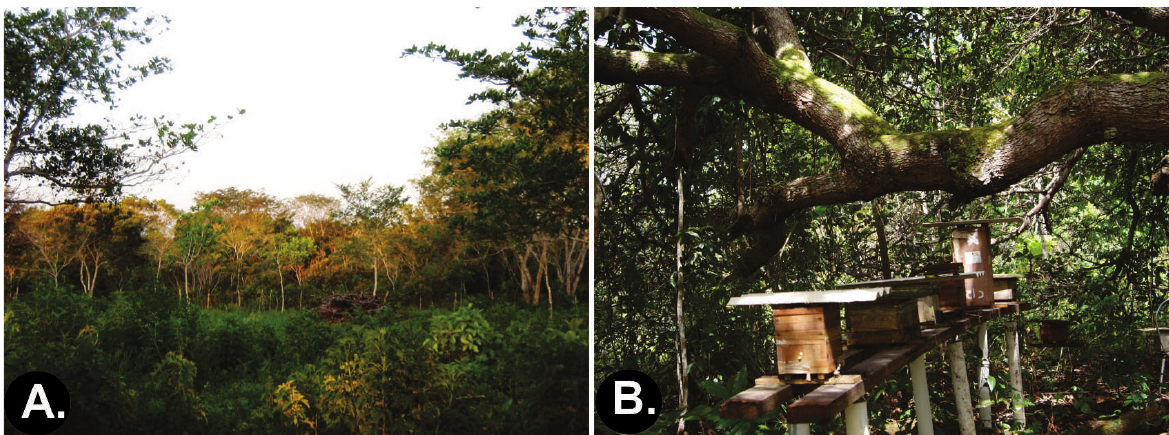
Fig 2. Study area. (A) General physiognomy of the local vegetation. (B) Meliponary implanted in an Atlantic Forest